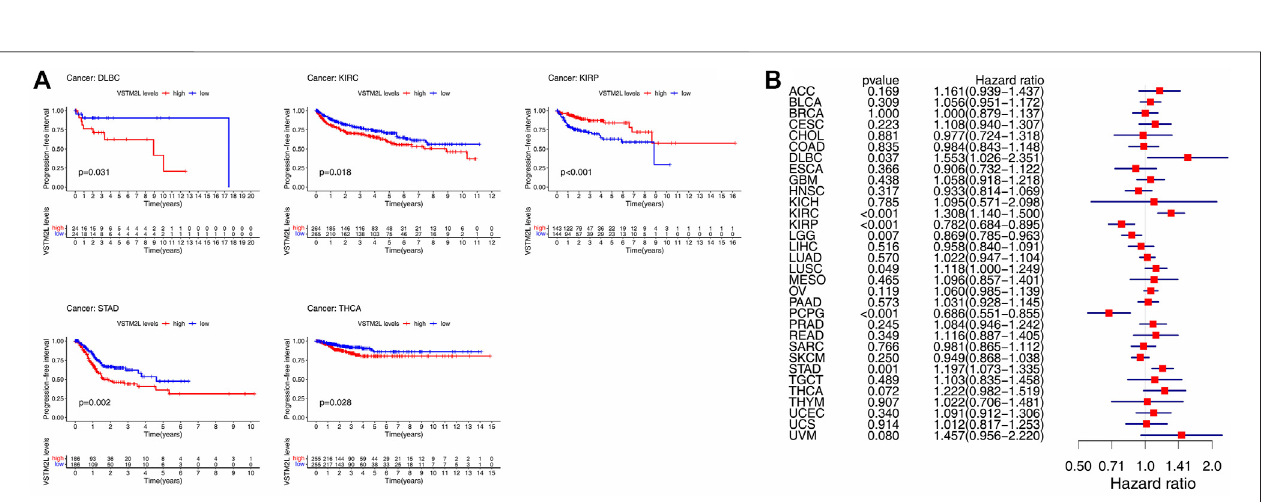
FIGURE 4 | Kaplan – Meier survival and Cox regression analyses of the prognostic value of VSTM2L expression level for PFI in different cancer types. (A) PFI accordingtohighandlow VSTM2L expressioninDLBC,KIRC,KIRP,STAD,andTHCAfromTCGA. (B) Correlationbetween VSTM2L mRNAexpressionlevelandPFIin various cancer types. * p <